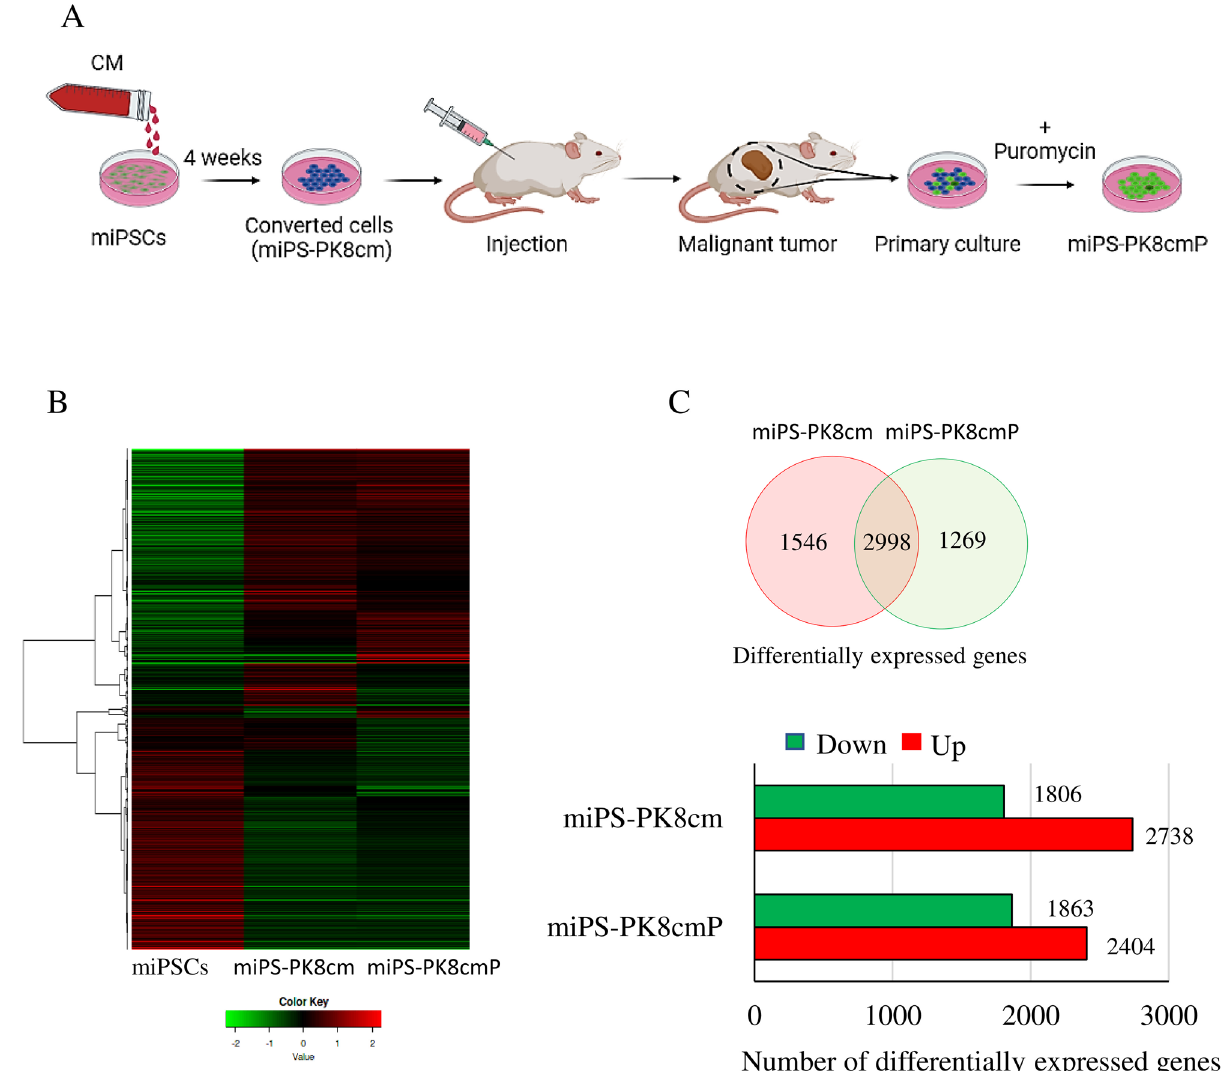
Figure 1. Analysis of transcriptomes of CSCs converted from miPSCs by RNA-seq. ( A ) Schematic chart of conversion of miPSCs into CSCs, converted cells were prepared by culturing miPSCs in 50% CM, then cells were transplanted into mice and CSCs were isolated from the primary culture of the tumors. ( B) A heat map of gene expression in miPSCs, miPS-PK8cm, and miPS-PK8cmP cells. ( C) A Venn diagram showing the differentially expressed genes in miPS-PK8cm and miPS-PK8cmP cells when compared with those in miPSCs and the bar graph depicting the number of up- and downregulated genes in miPS-PK8cm and miPS-PK8cmP cells when compared with those in